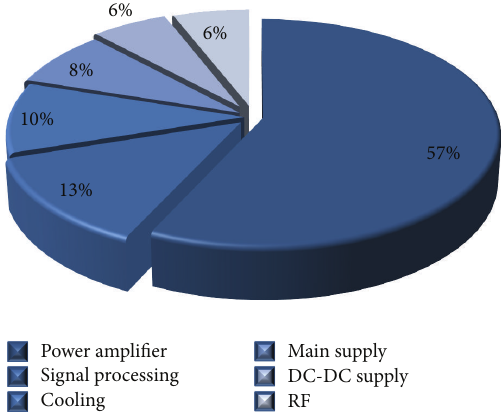
Figure 4: Distribution of energy consumption at a macrobase station